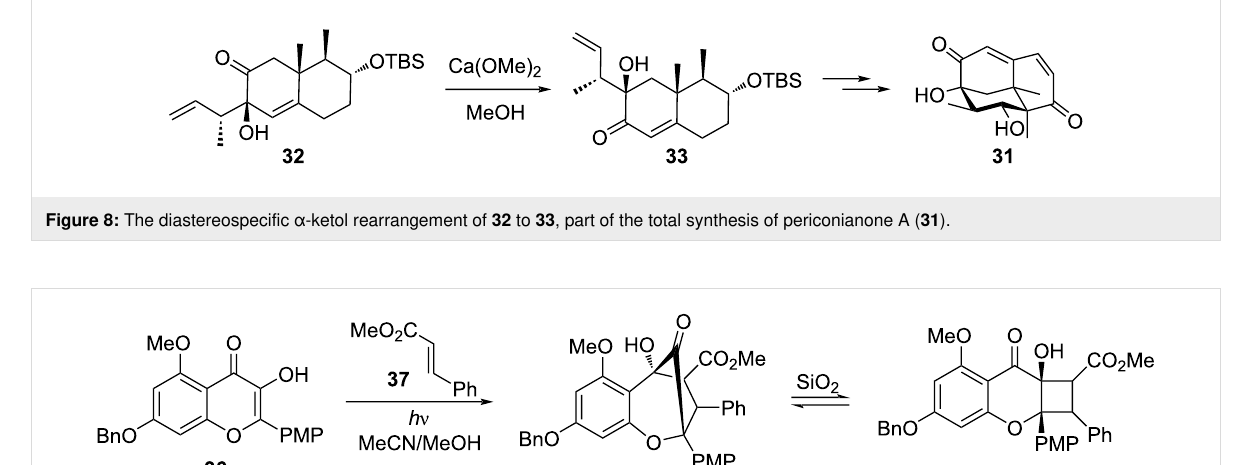
rangements have been initiated by a gold catalyst.